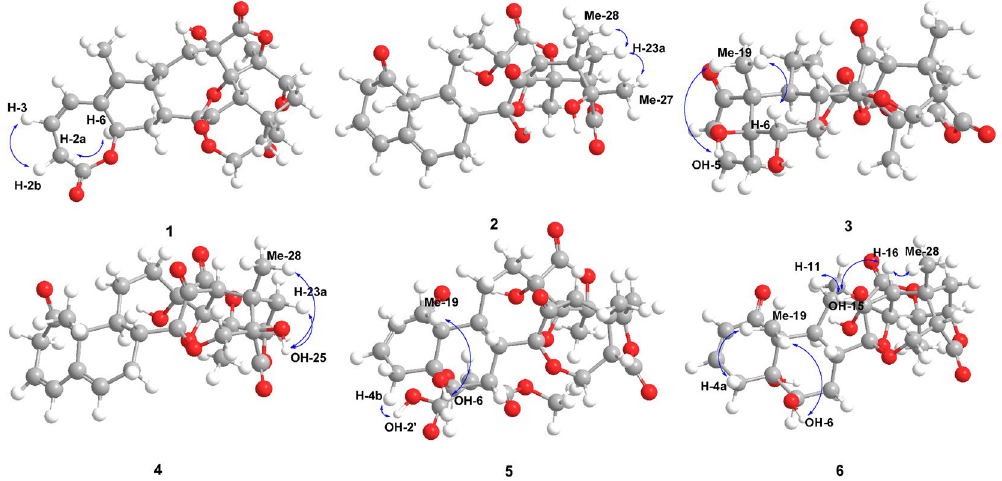
Figure 3. Selected NOESY correlations of compounds 1–6